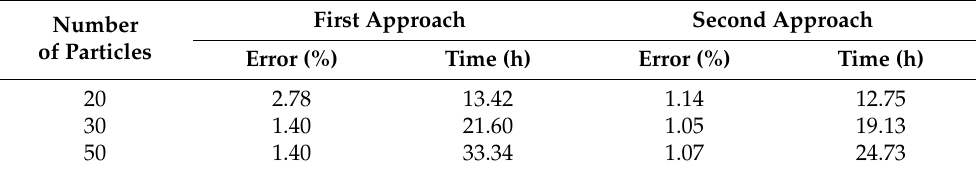
Table 10. Minimum objective function errors and calculation time of the PSO